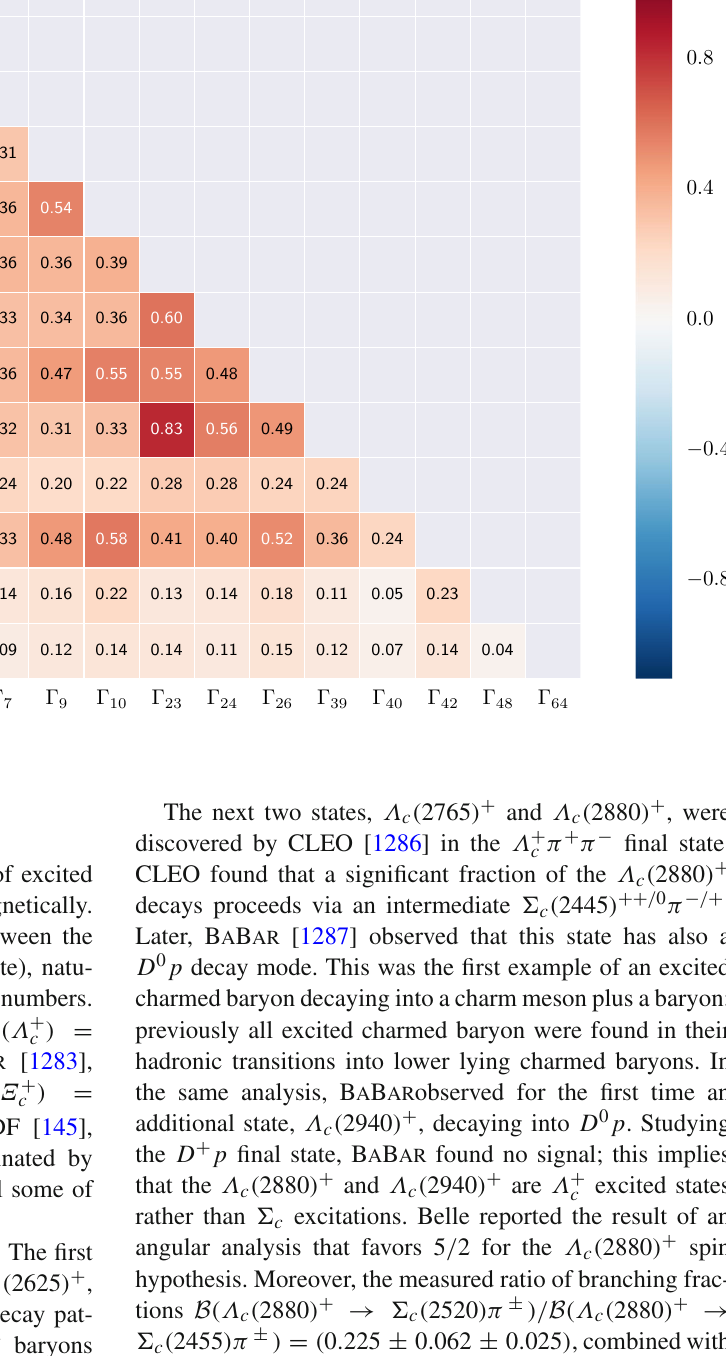
Fig. 214 Correlation coefficients between averaged Λ + c branching